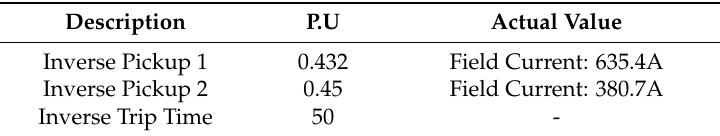
Table 5. Set values for